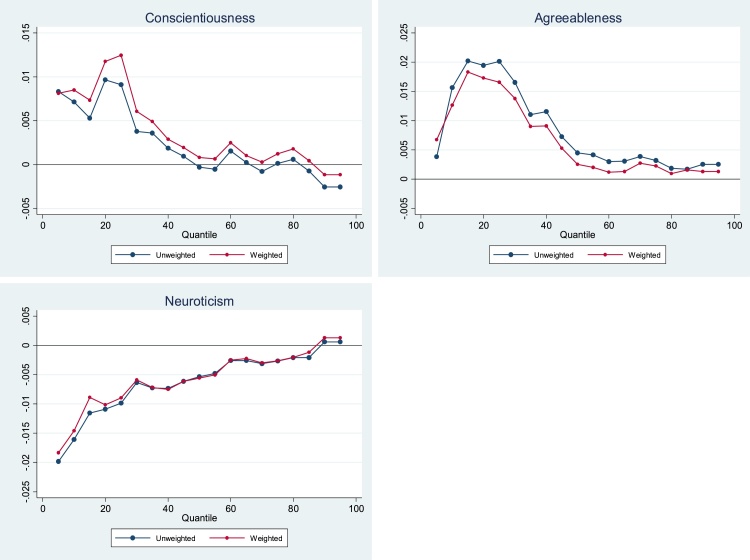
Weighted non-cognitive skills – SF-6D relationship.